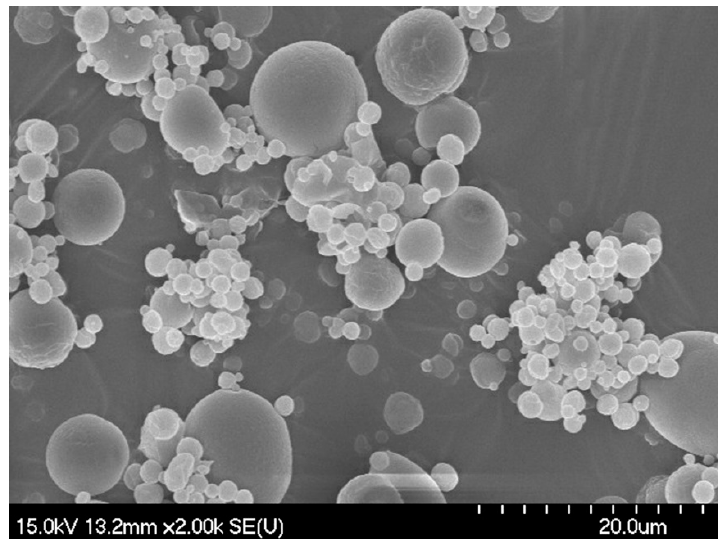
Figure 2. Scanning Electron Microscope (SEM) images of the spray-dried microcapsules.